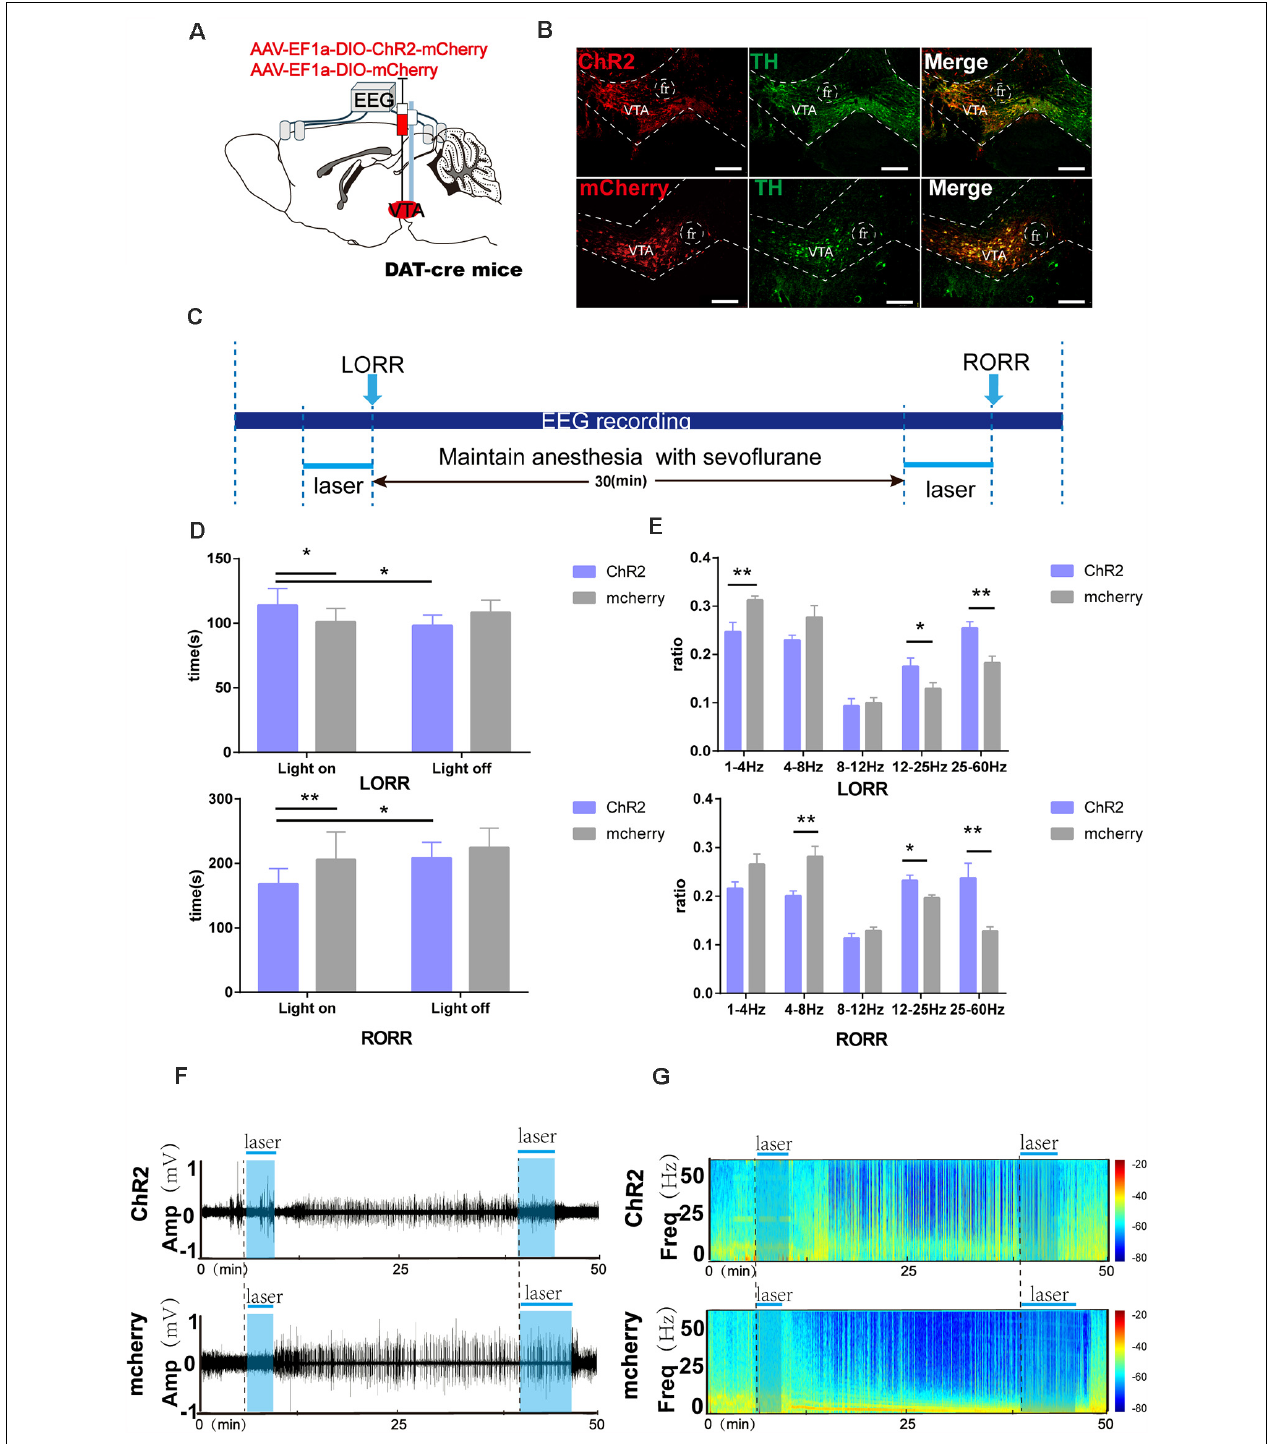
FIGURE 2 | Optogenetic activation of VTA-DA neurons facilitates arousal from sevoflurane anesthesia. (A) Diagram of the optogenetic virus injection and stimulation sites. (B) Expression of virus (mCherry, red) in VTA-DA neurons and colabeling with DA (TH immunofluorescence, green; scale bar: 200 µ m). (C) Schematic of the experimental time-course. (D) Optical activation of DA neurons in the VTA prolonged the induction time and shortened the emergence time from sevoflurane anesthesia. (E) Comparison of each Electroencephalogram (EEG) frequency band between the two groups during optogenetic activation of VTA-DA neurons. (F,G) Representative EEG traces and the corresponding heat map of the process in the two groups. Data are presented as the mean ± SD. * p < 0.05; ** p < 0.01, n = 8, by paired and unpaired t -test.